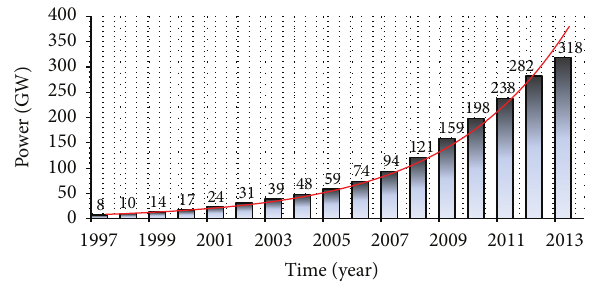
Figure 1: Wind power total capacity, 1997–2013.